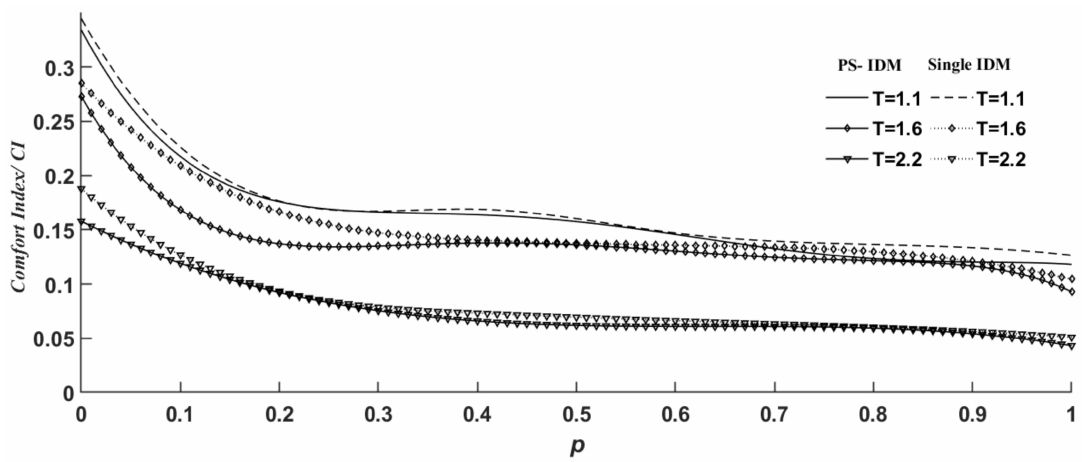
Figure 10. Comparison chart of the index before and after model